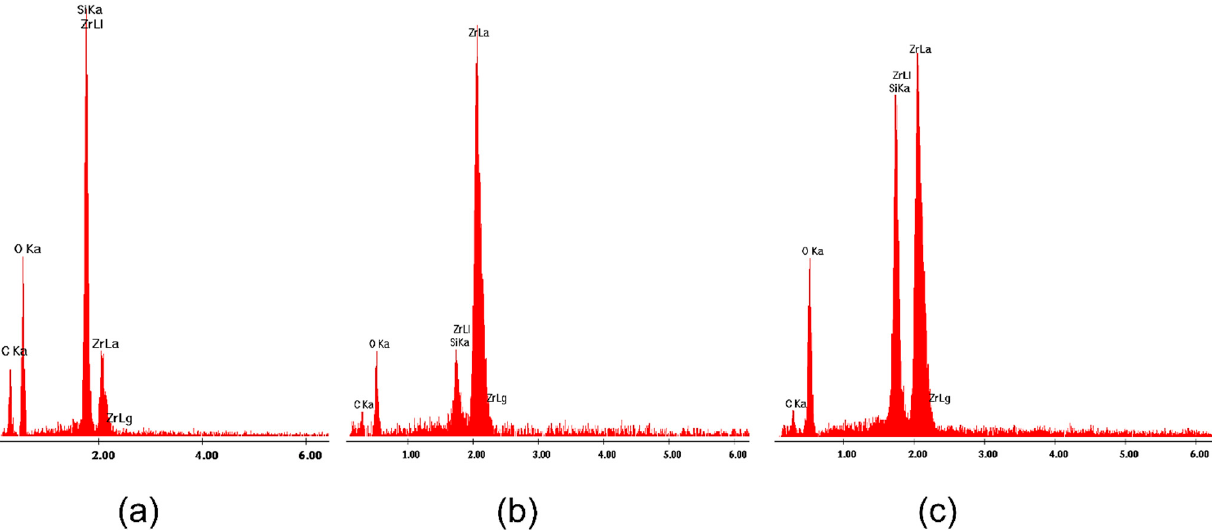
Figure 9 . EDS analysis of the whole studied surface of gels: ( a ) 4T (Figure 7b); ( b ) 1C (Figure 7c) and ( c ) 4C (Figure 7d).